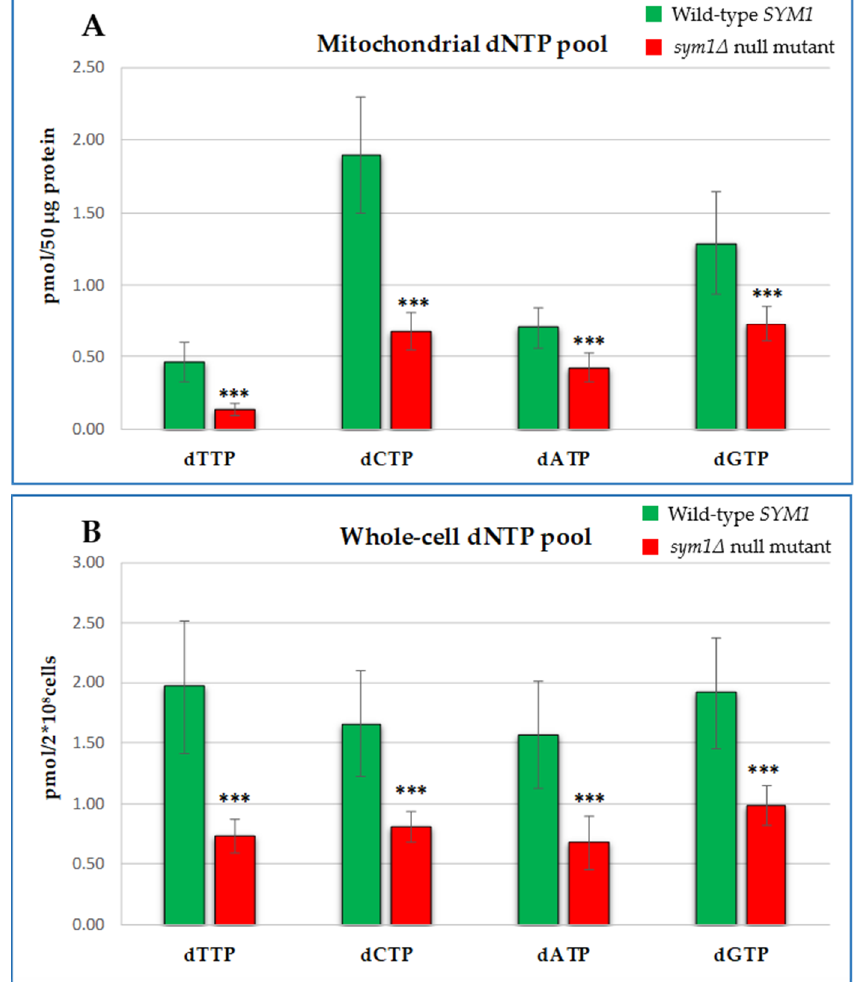
Figure 3. Mitochondrial ( A ) and whole cell ( B ) dNTP amount of the wild-type strain (green bar) and of the null mutant strain (red bar) grown for 24 h at 37 °C in SC medium supplemented with 0.6% glucose and 2% ethanol. Data are represented as the mean of at least eight values ± SD. Mitochondrial dNTP pool was reported as the amount of dNTP (in picomoles) per 50 μg of mitochondrial protein. Whole cell dNTP pools were reported as the amount of dNTP (in picomoles) per 2 × 10⁸ cells. Statistical analyses were performed using a two-tail unpaired Student’s t test: *** p < 0.001.